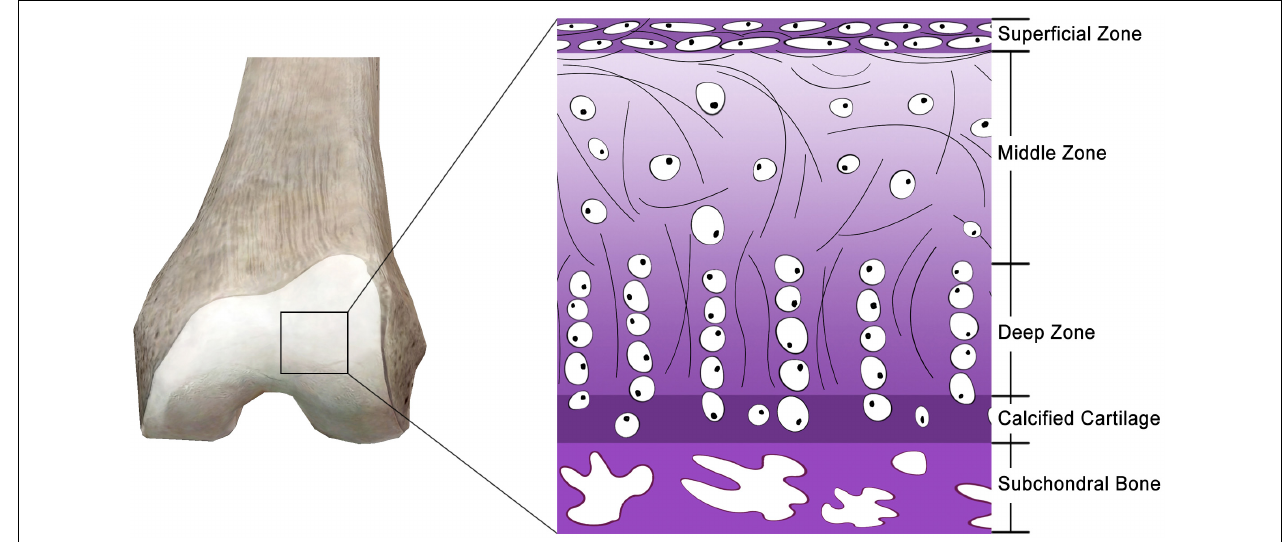
FIGURE 1 | Schematic depiction of articular cartilage and chondrocytes of the joint surface.